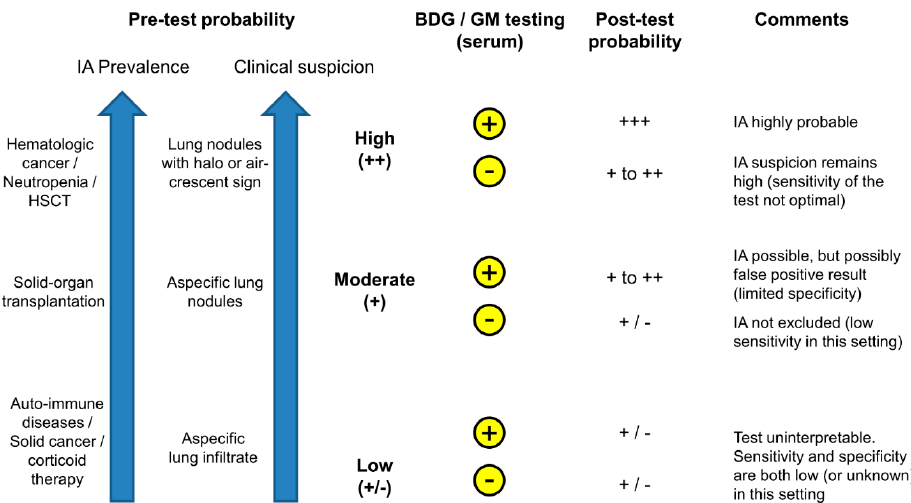
Figure 1. Proposed algorithm for the use of galactomannan (GM) and 1,3- β - D -glucan (BDG) testing for the diagnosis of invasive aspergillosis (IA) in clinical practice. Based on the following parameters: (1) prevalence of IA in a given population and (2) assessment of the clinical signs and symptoms of IA in a given patient, the clinician may establish the individual pre-test probability on a scale from low to high. While testing of GM and/or BDG may be useful in cases with moderate-high pre-test probability (by changing the post-test probability), interpretation of a positive or negative test is often inconclusive in low risk settings. HSCT: hematopoietic stem cell transplantation. Yellow circles: + positive test, - negative test.